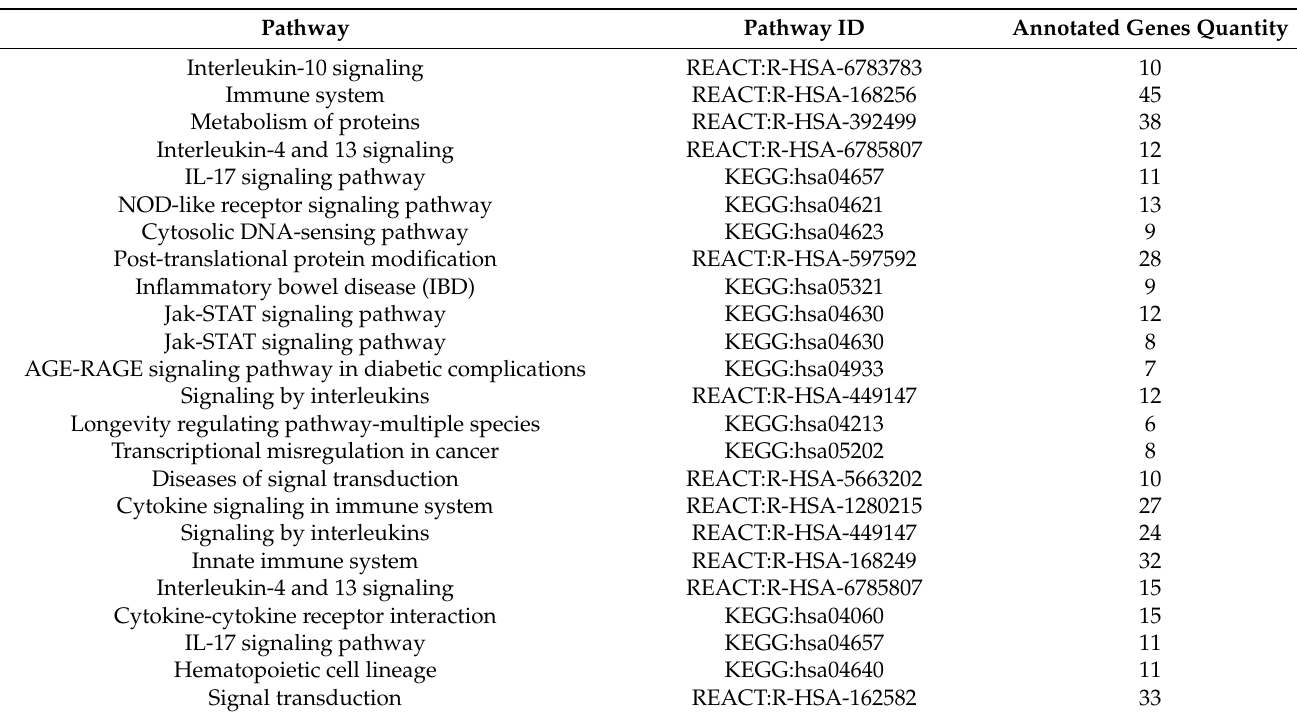
Figure 3. Network result from the most connected nodes. Color shades represent connection degrees from most connected (yellow) to less connected (red). Table 1. Enrichment analysis of pathways altered by theophylline in